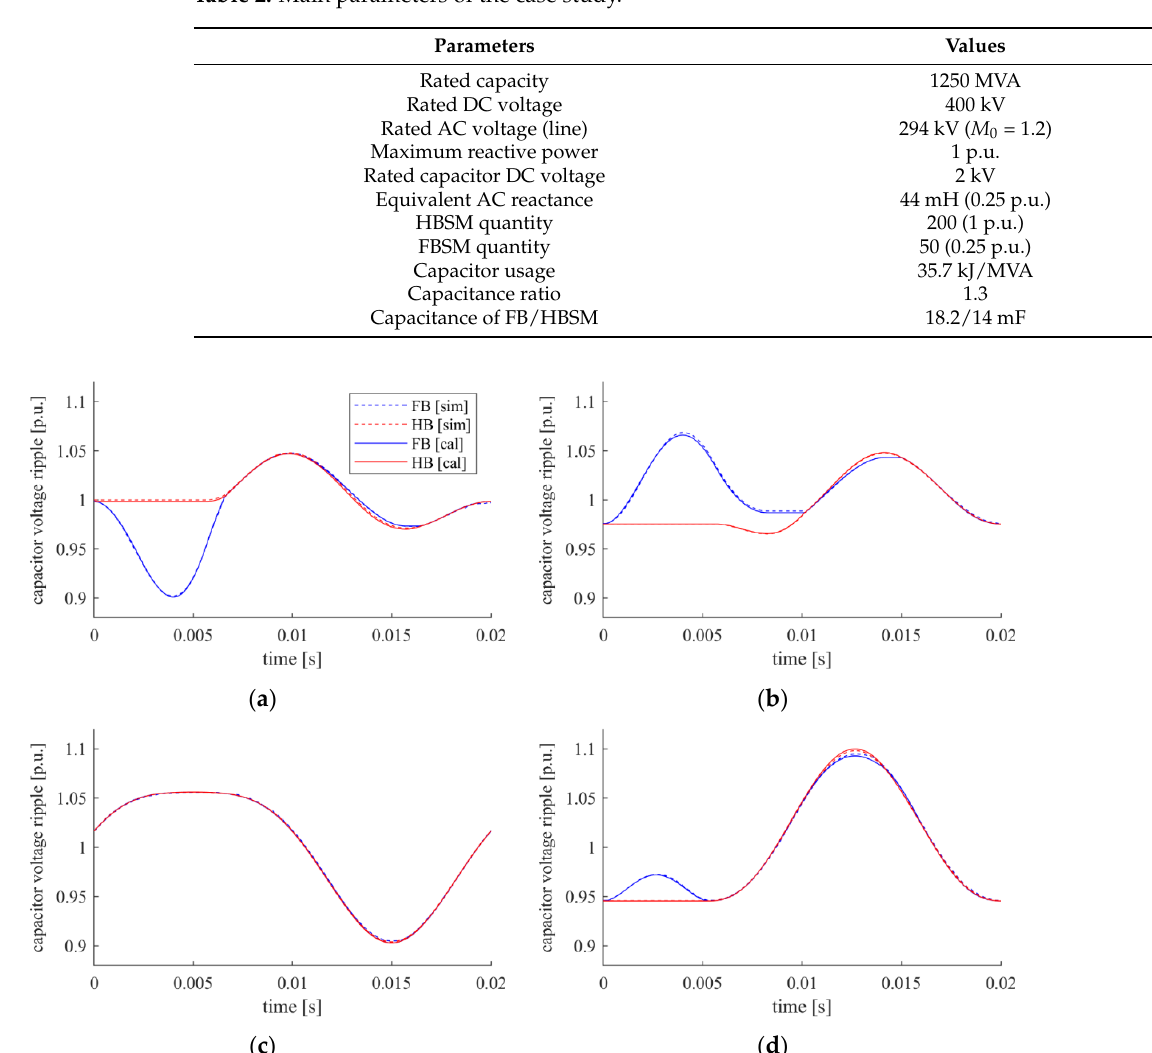
Table 2. Main parameters of the case study.